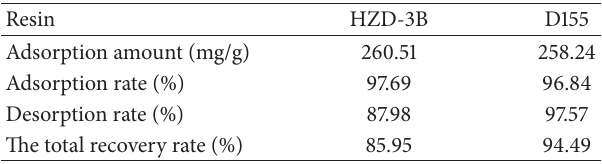
Table 3: Factors and levels in 𝐿 9 (3 3 ) orthogonal array and desorp- tion efficiencies in different media.